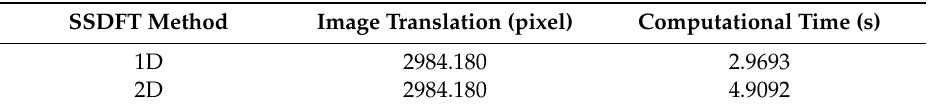
Table 1. Registration speed and accuracy comparison between 1D and 2D single-step discrete Fourier transform (SSDFT)